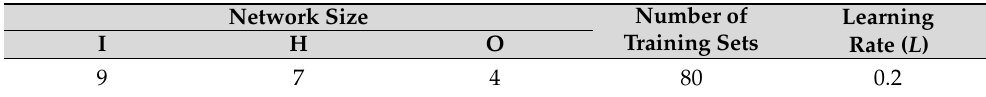
Table 4. Architecture of the